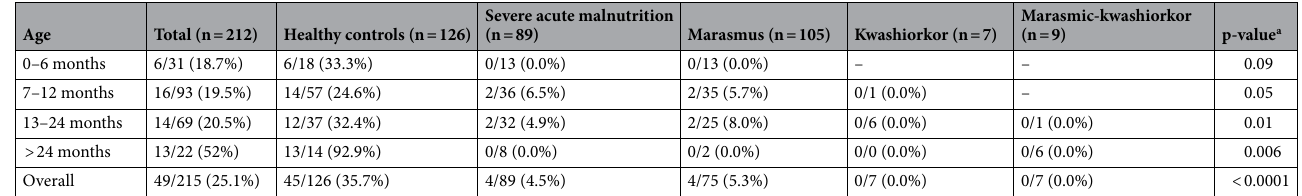
Table 3. Proportion of detection of Methanobrevibacter smithii in children according to age and nutritional status excluding children with diarrhea, emesis and gastroenteritis—weighted data (n = 215). a Weighted